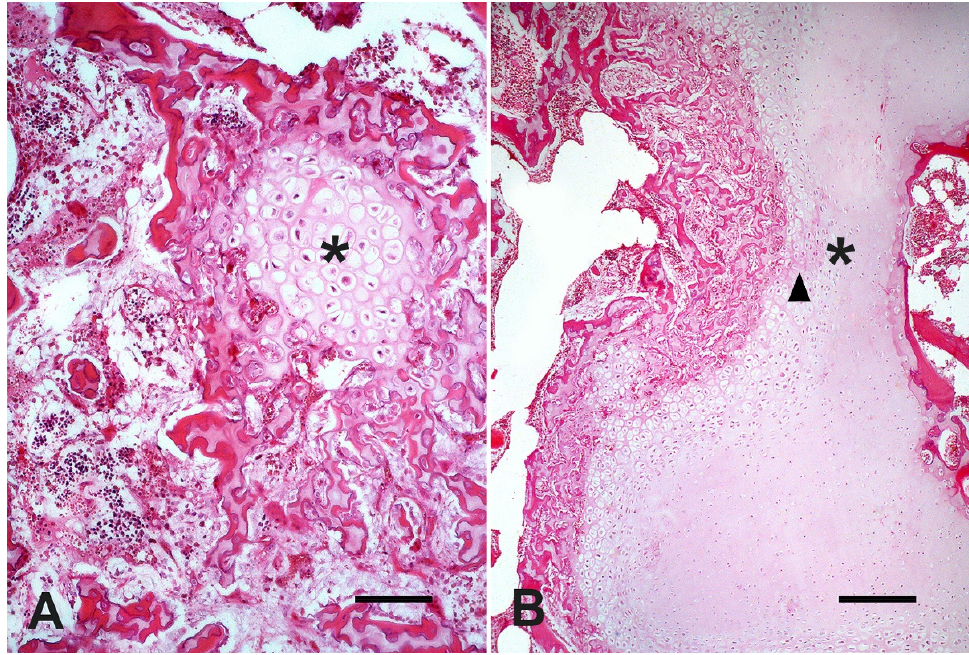
Figure 2. Cranial metaphyseal bone of the C4 vertebra of a four-month-old Nelore calf. ( A ) Abnormal area of dystrophic hyaline cartilage development (asterisk) (H&E, bar = 100 μ m). ( B ) Cartilaginous growth failure (asterisk) and interstitial sclerosis of hyaline cartilage (arrowhead) (H&E, bar = 250 μ m).